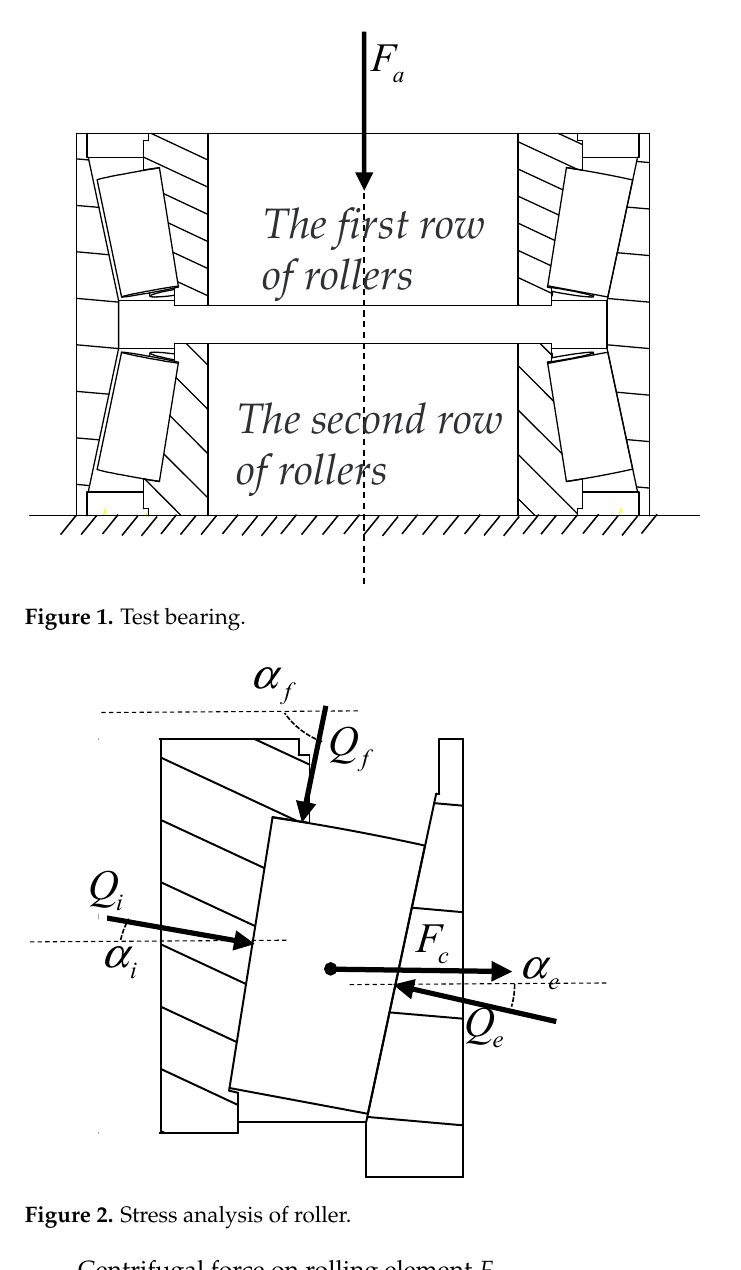
Figure 2. Stress analysis of roller.